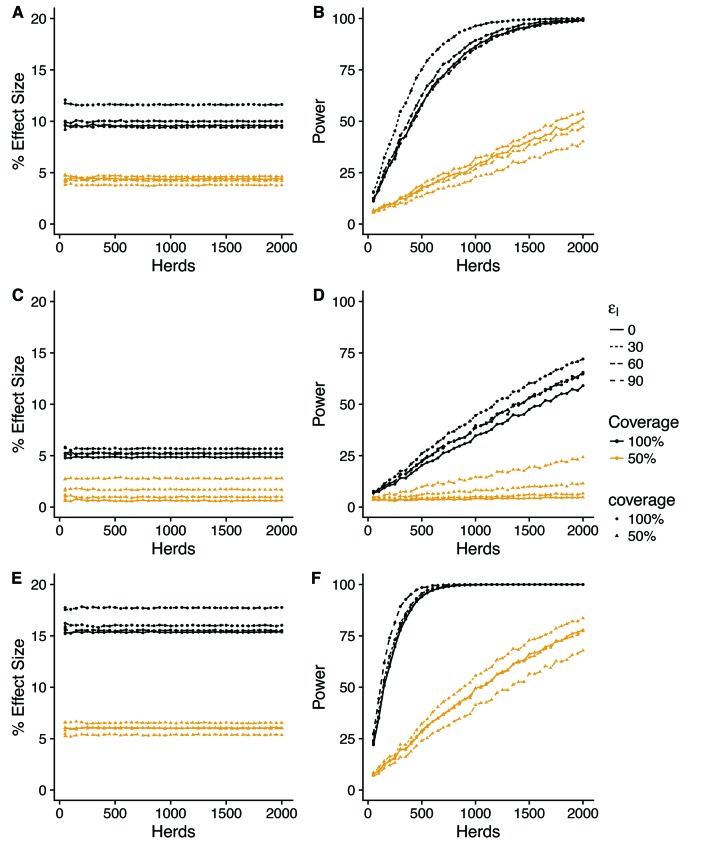
Predicted effect of vaccination on duration of restrictions (SOR model).Simplest design to measure vaccine effectiveness with 50:50 mix of control and vaccinated herds and a target coverage of either 50 or 100% for a 3-year trial period. We explore a range of assumed vaccine-induced reductions in susceptibility (A,B) εS=60%(C,D) εS=60%(E,F) εS=90% and infectiousness (εI = 0, 30, 60, 90%). For an assumed vaccine efficacy of 90% (reduction in susceptibility), the SOR model predicts a ~ 15% reduction in prolonged breakdowns (defined as the proportion of herds that take more than 1 short interval test to clear restrictions) for 100% vaccination coverage and ~ 5% for 50%. For this effect size, ~ 400 herds would be required to achieve the target 80% trial power for whole herd vaccination. In excess of 2000 herds (the upper range considered) would be required for a 50% within herd target coverage.